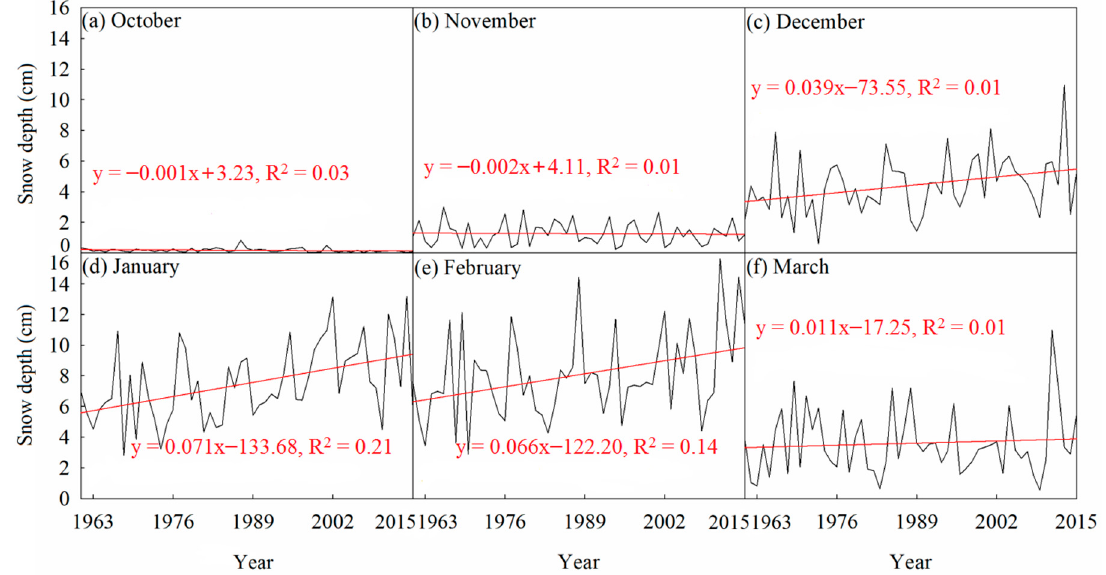
Figure 2. Temporal variation of monthly snow depth (cm) over 1961–2015 in Xinjiang: ( a ) October, ( b ) November, ( c ) December, ( d ) January, ( e ) February and ( f ) March.